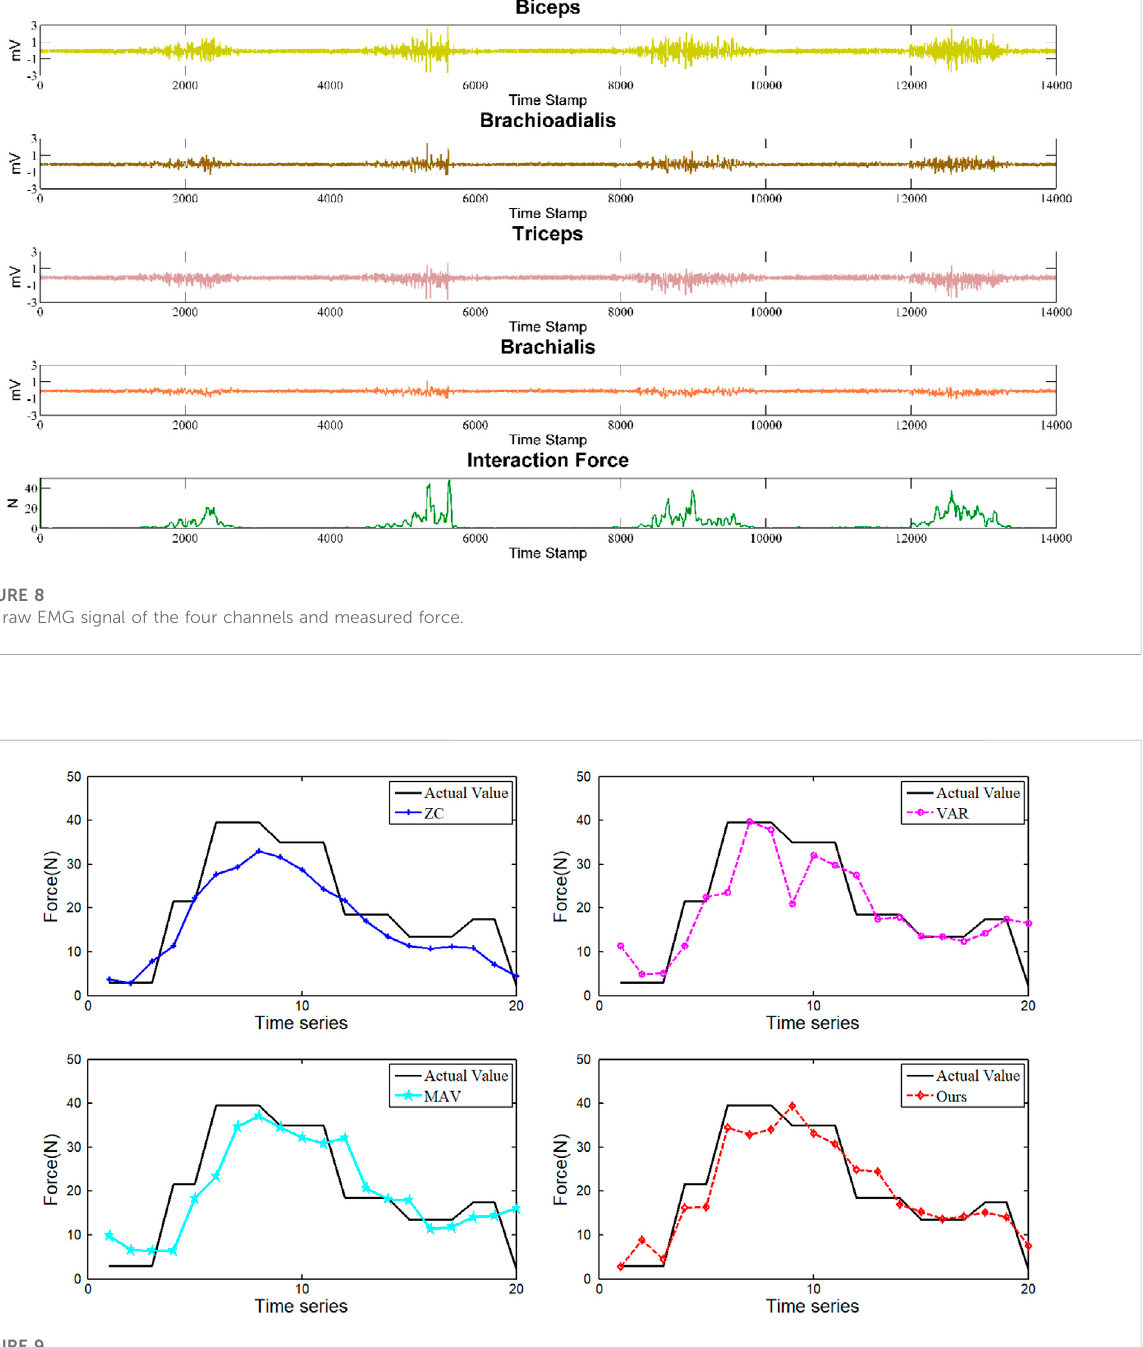
FIGURE 9 Comparison of interaction force prediction results under different